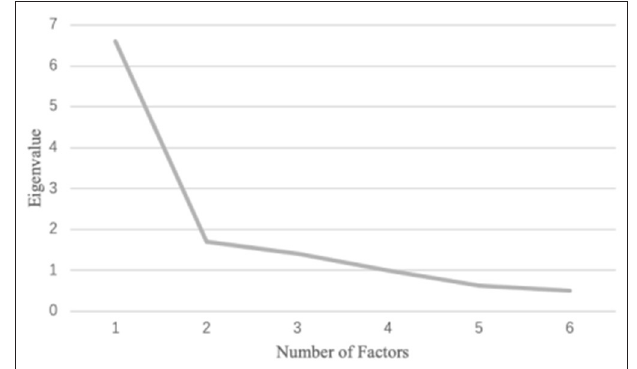
FIGURE 1 | Screen plot for the first exploratory factor analysis with 14 items.